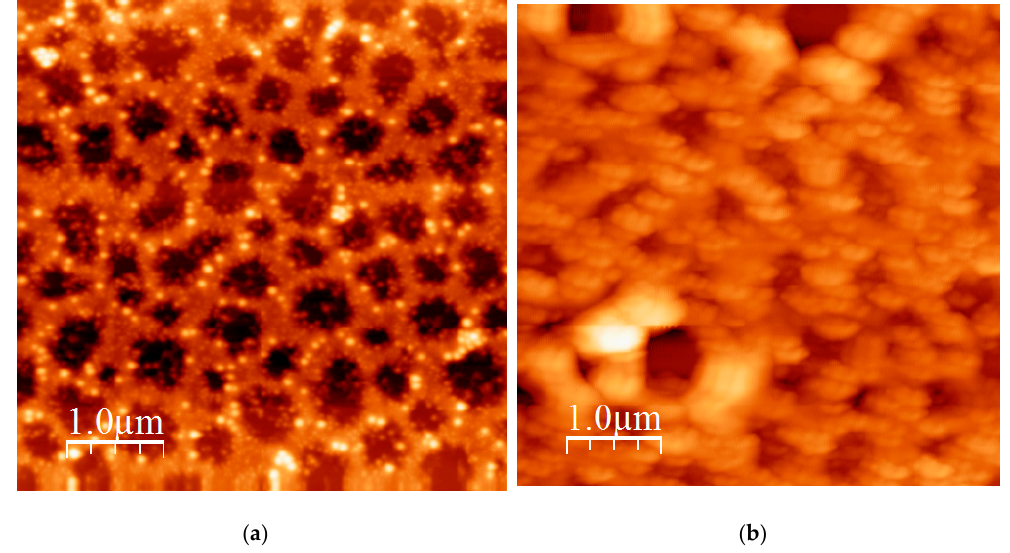
Figure 11. ( a ) AFM height image of HISIH and ( b ) AFM phase image of HISIH.